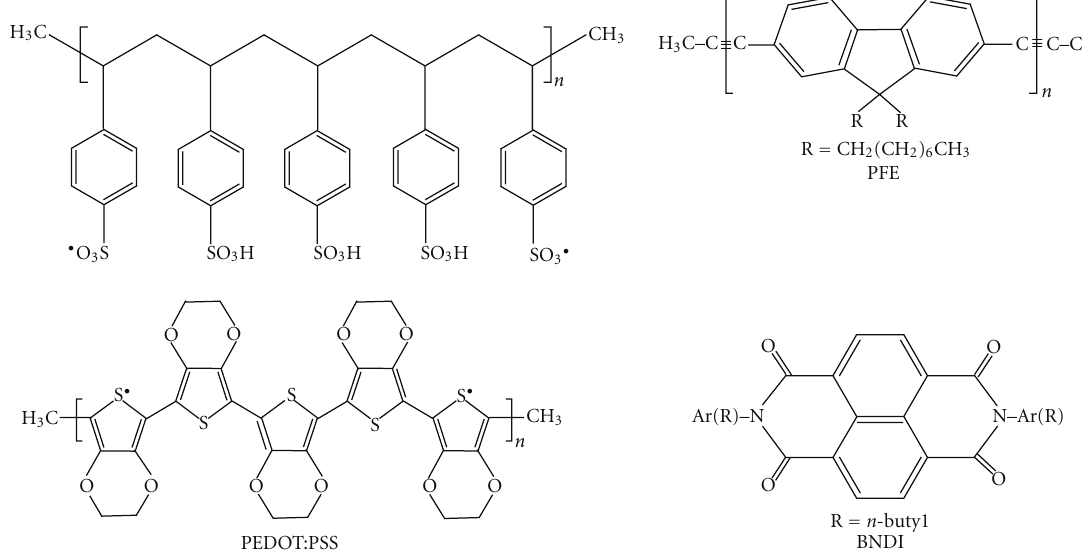
Figure 1: Chemical structures of PEDOT:PSS, PFE, and